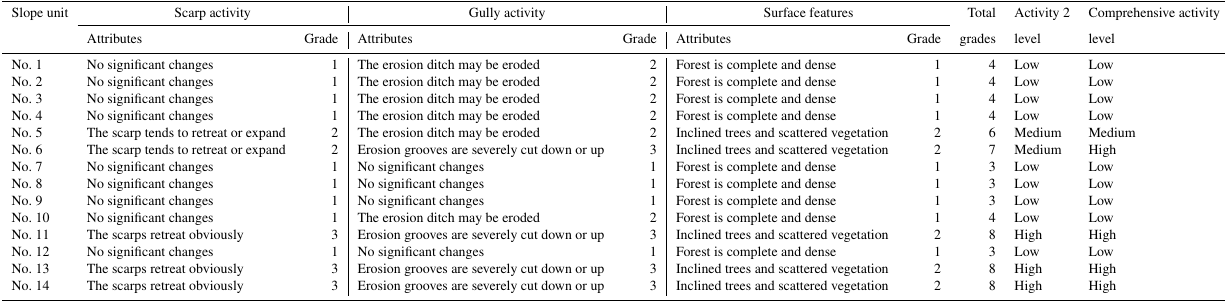
Table 14. Corresponding grades and levels of Activity 2 of slope units around the Neikuihui tribe. Slopeunit